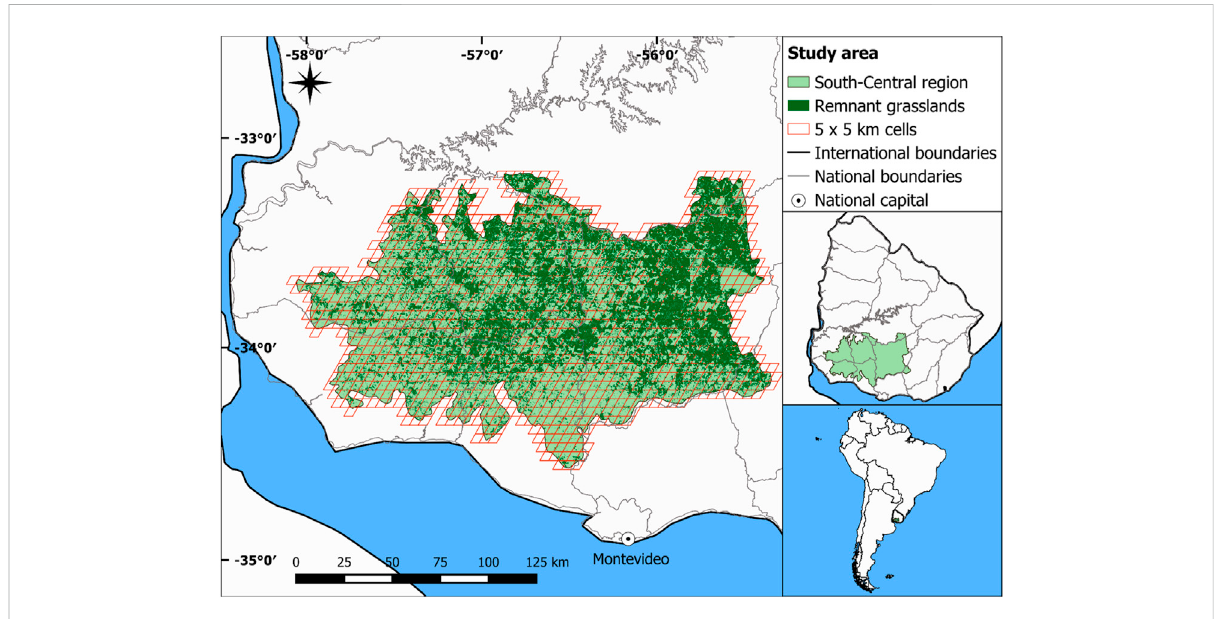
FIGURE 3 Study area. The conservation value has been determined for each cell of 5 x 5